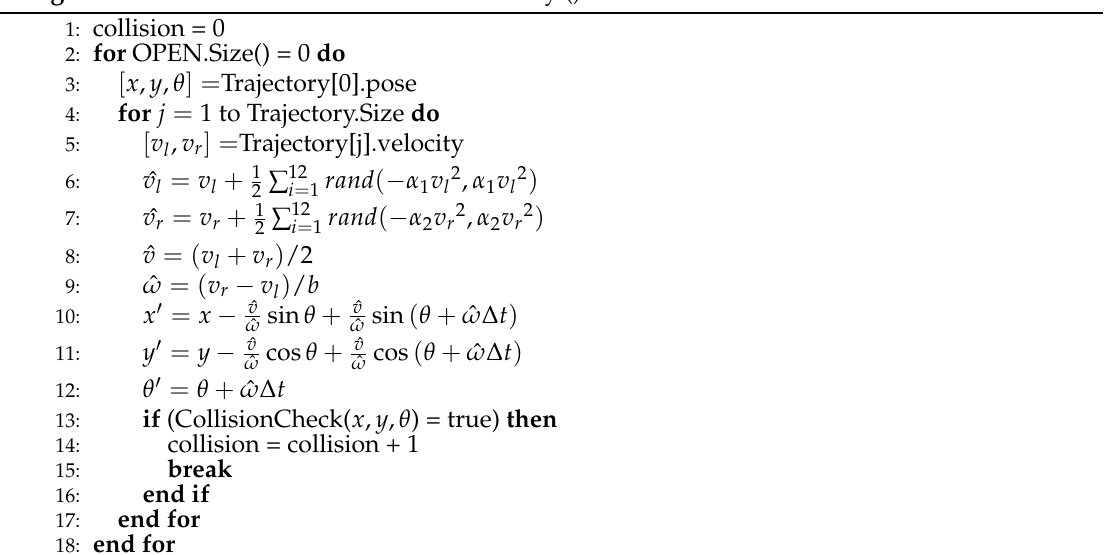
Algorithm 3: SimulationWithMotionUncertainty ().